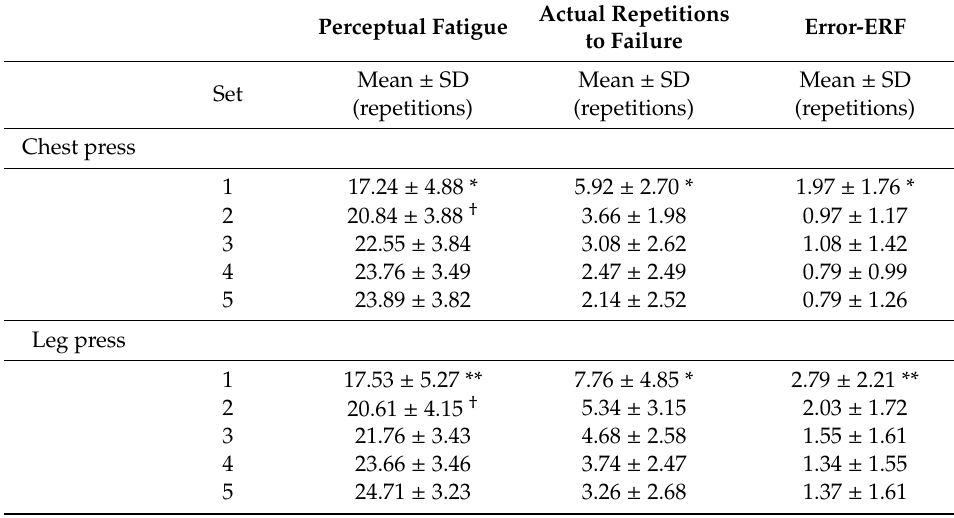
Table 1. Perceptual fatigue responses, actual repetitions to failure and error-ERF during sets of the chest press and the leg press.